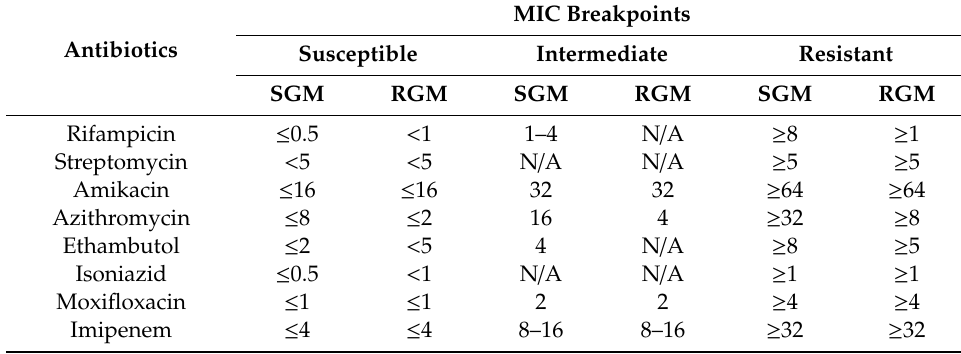
Table 2. MIC ( µ g / mL) thresholds of 8 antimicrobial agents for slowly growing mycobacteria (SGM) and rapidly growing mycobacteria (RGM). MIC Breakpoints Antibiotics Susceptible